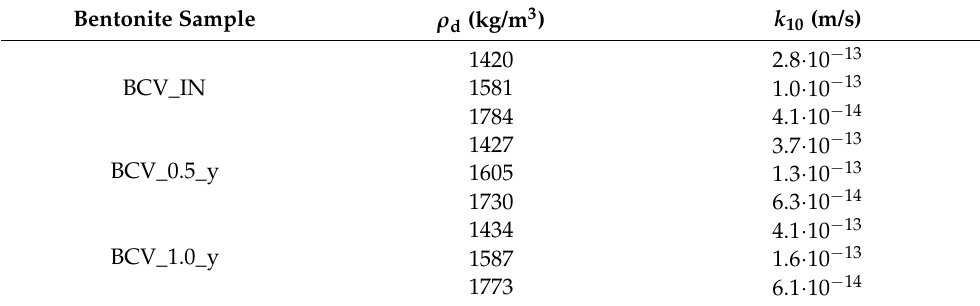
Table 5. Saturated hydraulic conductivity k 10 data for studied samples at actual bentonite dry density ρ d